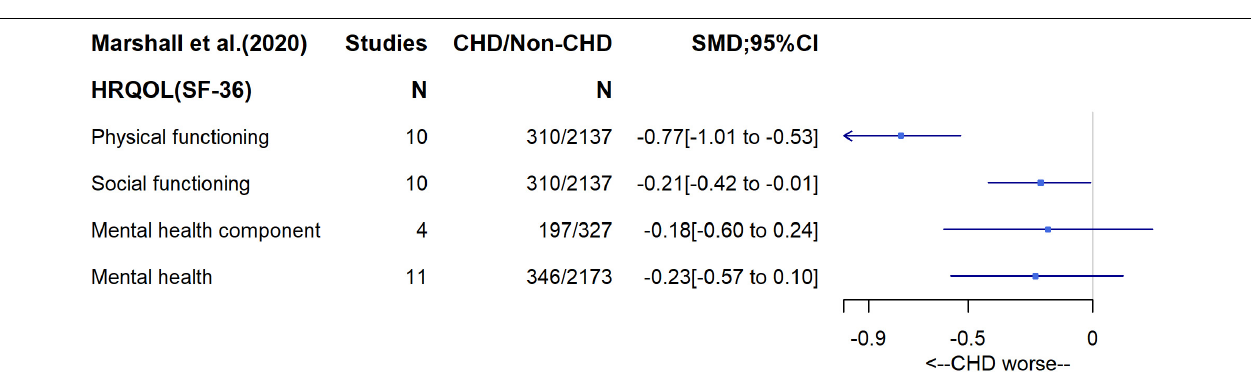
FIGURE 6 | Standardize mean difference for health-related quality of life domains